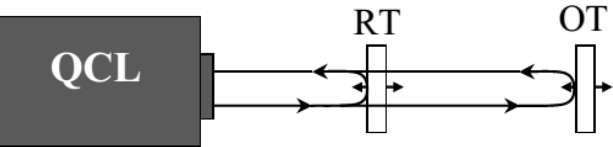
Figure 1. Scheme of the proposed